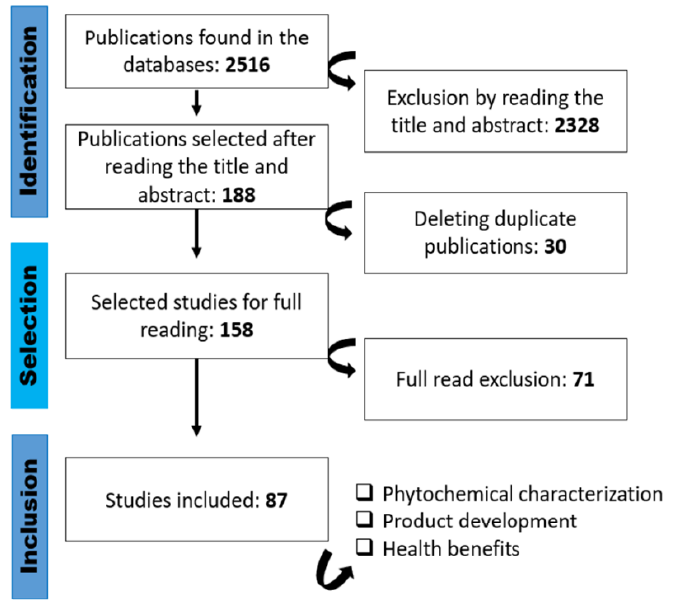
Figure 6. Flowchart of the selection of studies by stages (Authors, 2022).